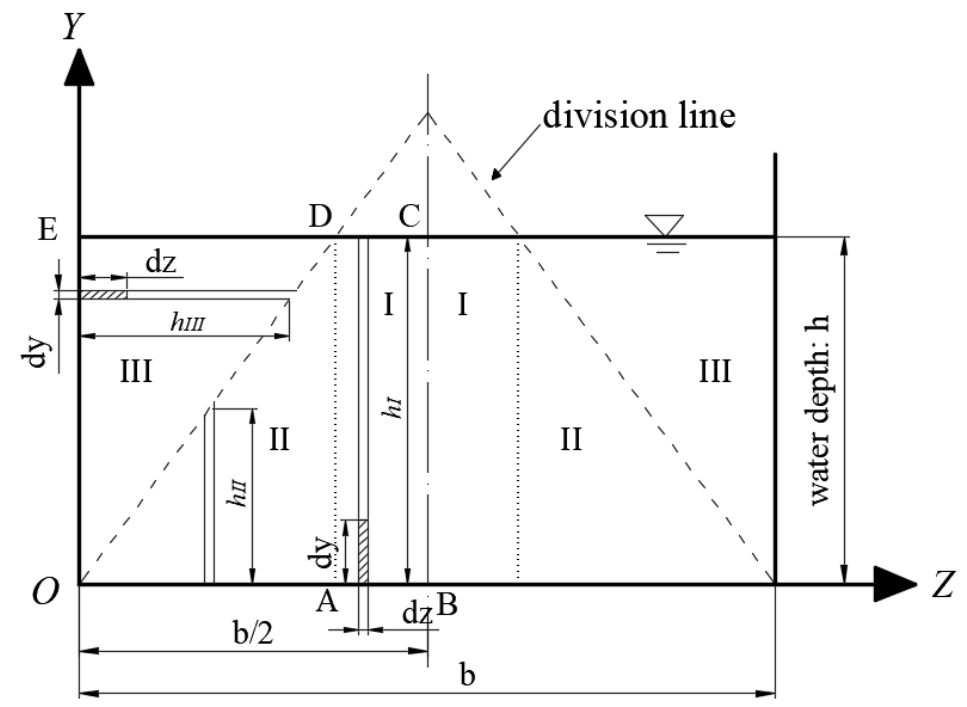
Figure 2. Flow partitioning in rectangular channels.